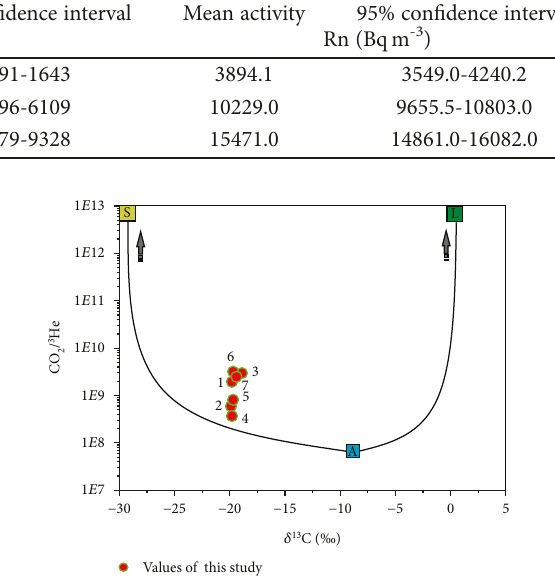
Figure 9: Plot showing CO / 3 He versus δ 13 C values for gas samples 2 from the shallow depth wells. A: air end-member; L: limestone end-member; S: sediment end-member.